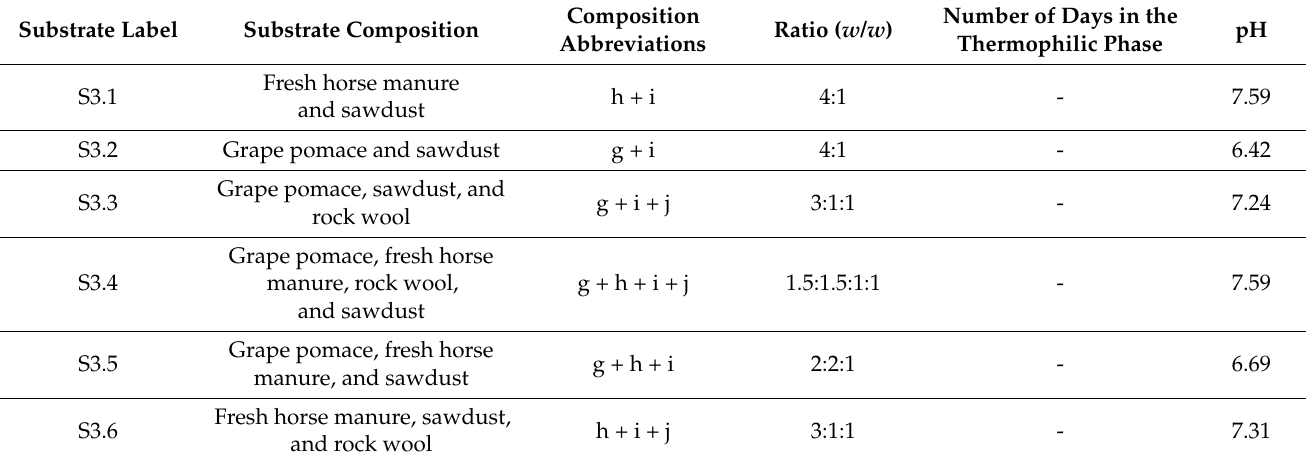
Table 3. Details of the third set of